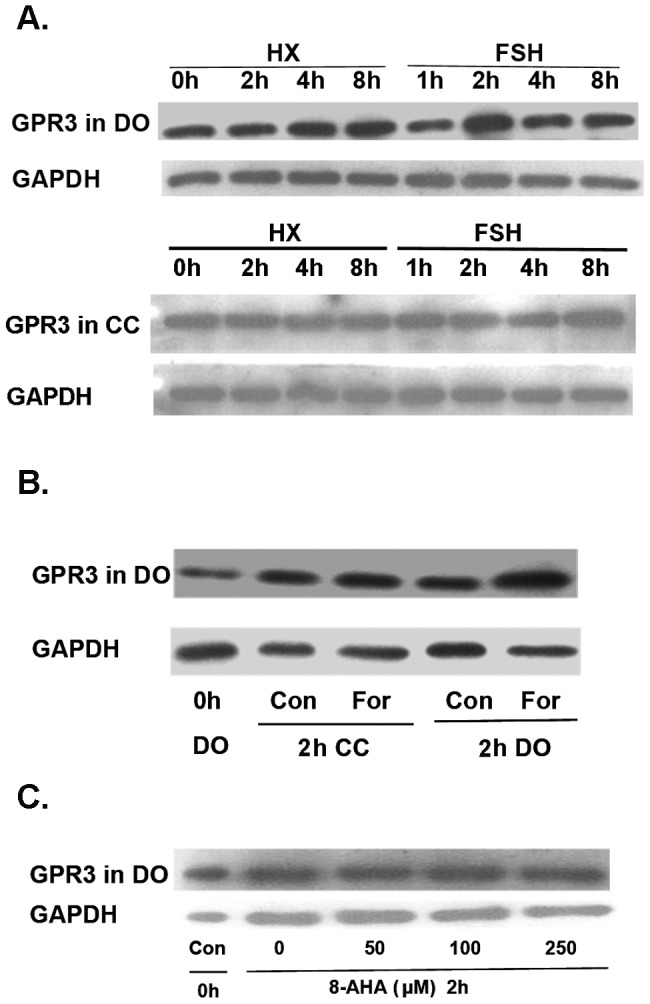
GPR3 levels are increased by FSH, as well as the activation of AC but not PKAI.(A) FSH increased GPR3 levels in DOs, but not CCs, at 2 h, during the resumption of meiosis. DOs and CCs from 200 COCs treated/not treated with FSH were collected at various time points and analyzed by Western blotting. (B) Forskolin (For) upregulated GPR3 levels in DOs, but not CCs. COCs were incubated in HX medium supplemented with 5 µM forskolin for 3 h. Oocytes of COCs were collected at 2 h for Western blot analysis of GPR3 levels. (C) Direct activation of PKAI had no effect on the change in GPR3 levels. COCs were incubated in HX medium supplemented with increasing concentrations of 8-AHA-cAMP (0–250 µM) for 2 h; Oocytes of COCs were collected at 2 h for Western blotting analysis of GPR3. Western blotting experiments were performed at least three times with similar results. The blot shown is representative of three experiments.